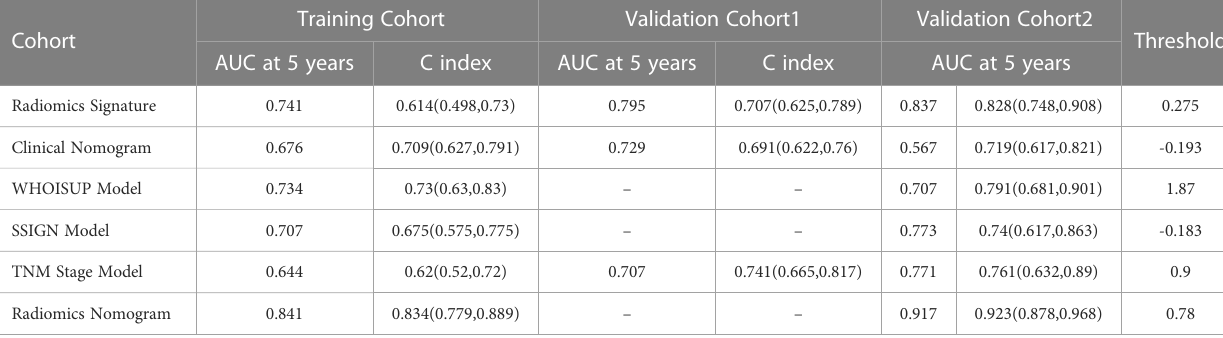
TABLE 1 Performance of six prognostic models in training and validation